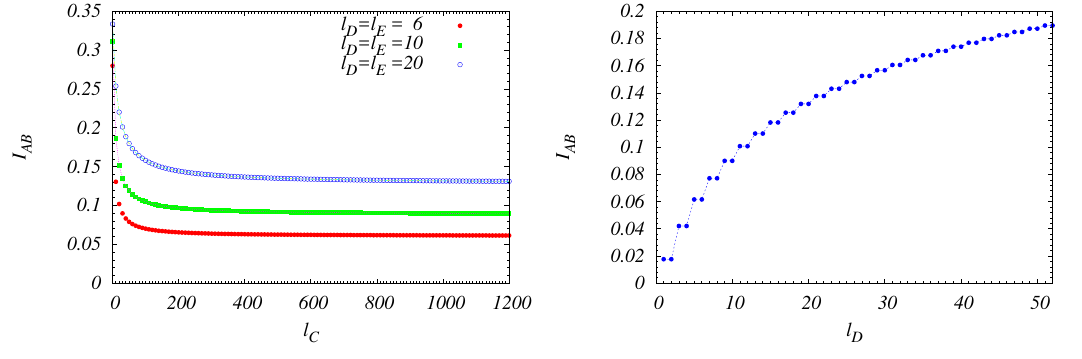
Figure 11: (Left) Mutual information between two spins in the bulk of a colorless = (cid:96) = 6,10,20 from the edges, as a function of the Fredkin chain at distances (cid:96) D E relative distance (cid:96) ; (Right) Mutual information between two spins in the bulk as a C = (cid:96) function of the distance (cid:96) from the edges for colorless Fredkin chain with size D E L =